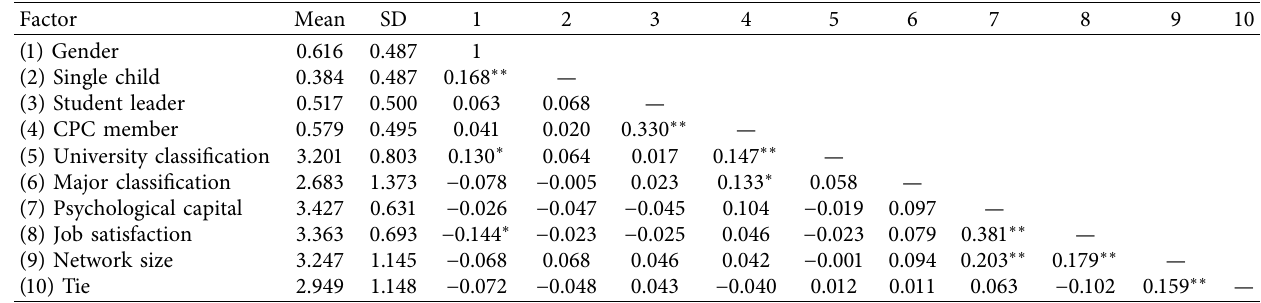
Table 4: Means, SDs, and correlations of study